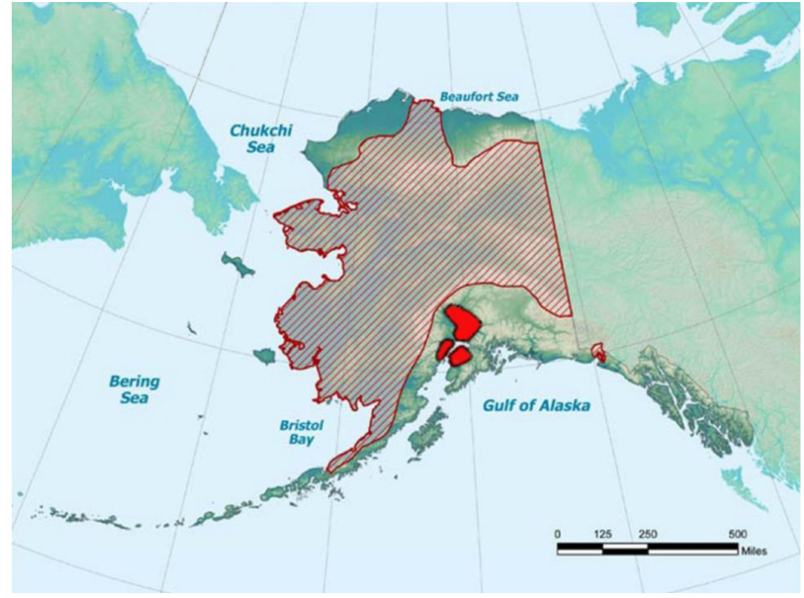
Figure 1. Native and invasive ranges of pike in Alaska. Native range in dashed area; invasive range in solid